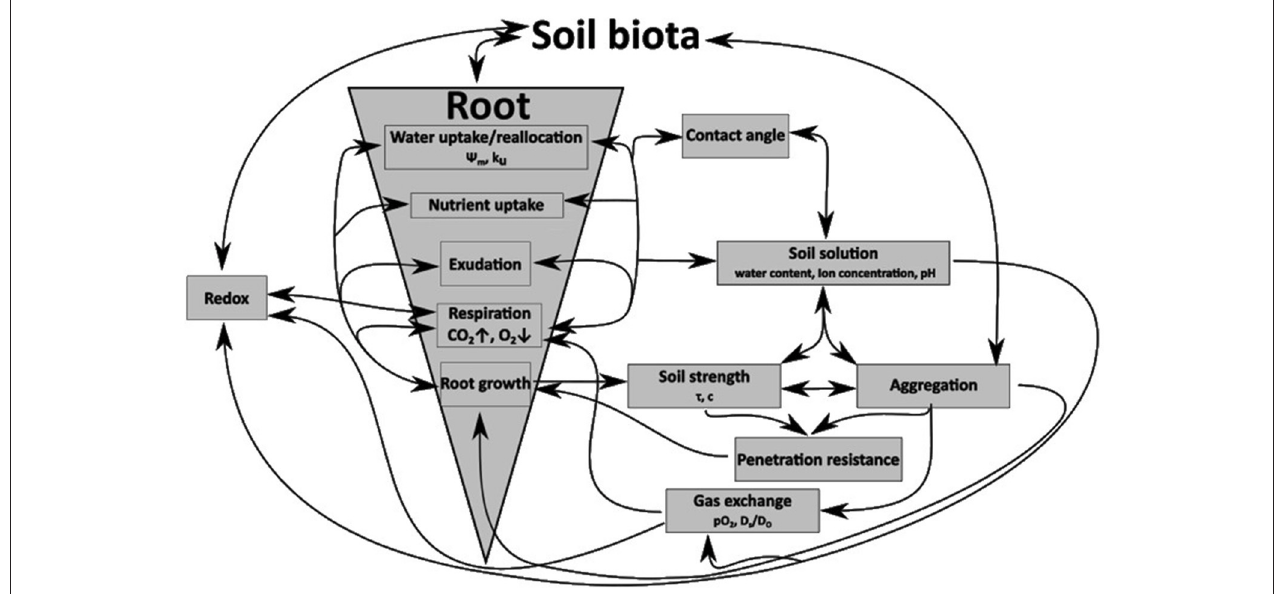
FIGURE 1 | Schematic diagram of the interactions between roots, growth processes, and interactions with the mineral soil phase and their influence of physico-chemical soil